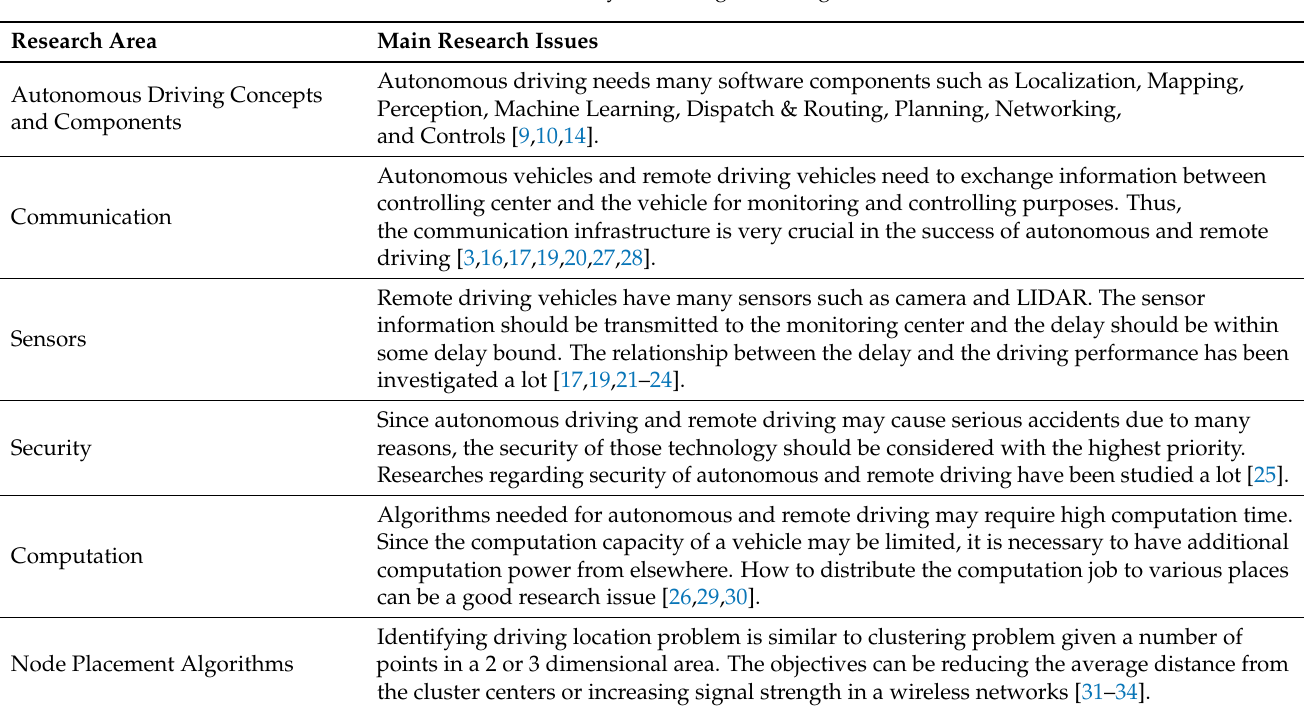
Table 1. Summary of existing